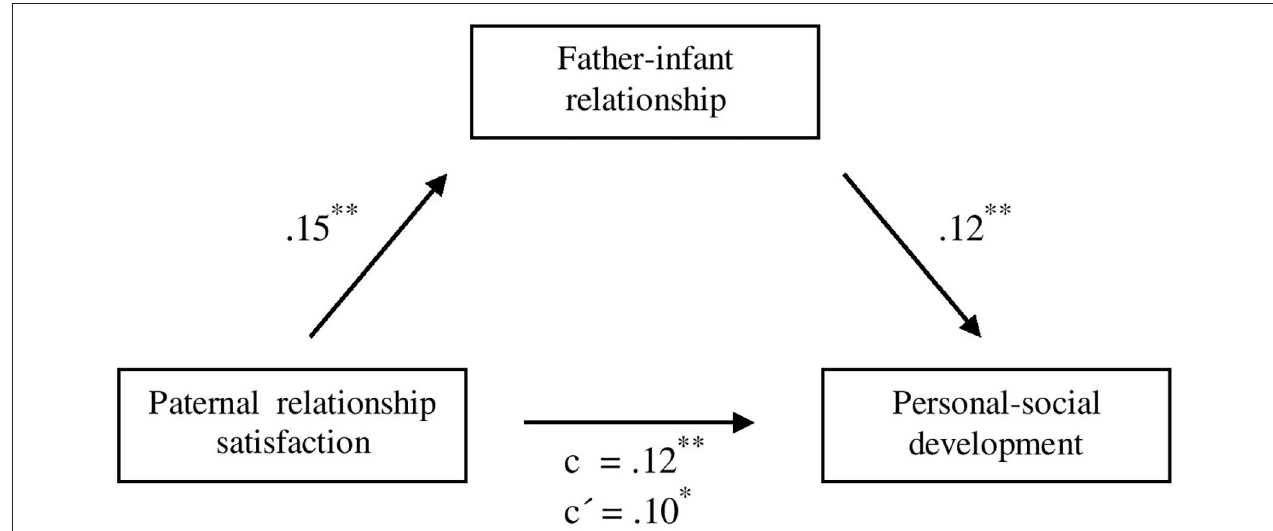
FIGURE 1 | Mediation analysis for the prospective association of paternal relationship satisfaction on infant personal-social development, mediated by father-infant relationship, controlled for parental age, education, infant gender, infant health, and premature birth. Specification of the standardized regression coefficients ( β ); c = total effect; c ′ = direct effect. * p < 0.05. ** p < 0.01. N = 583–585.